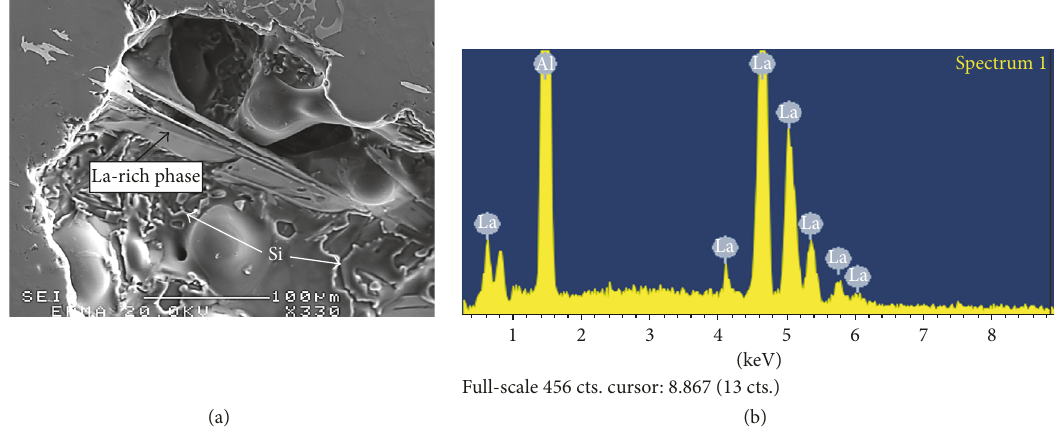
Figure 17: (a) Secondary electron image showing porosity in A356 alloy containing 1.025 wt.% La and no Sr (sample SDAS ∼ 42 𝜇 m). (b) EDS spectrum corresponding to the La-rich phase platelet (black arrow) in (a).